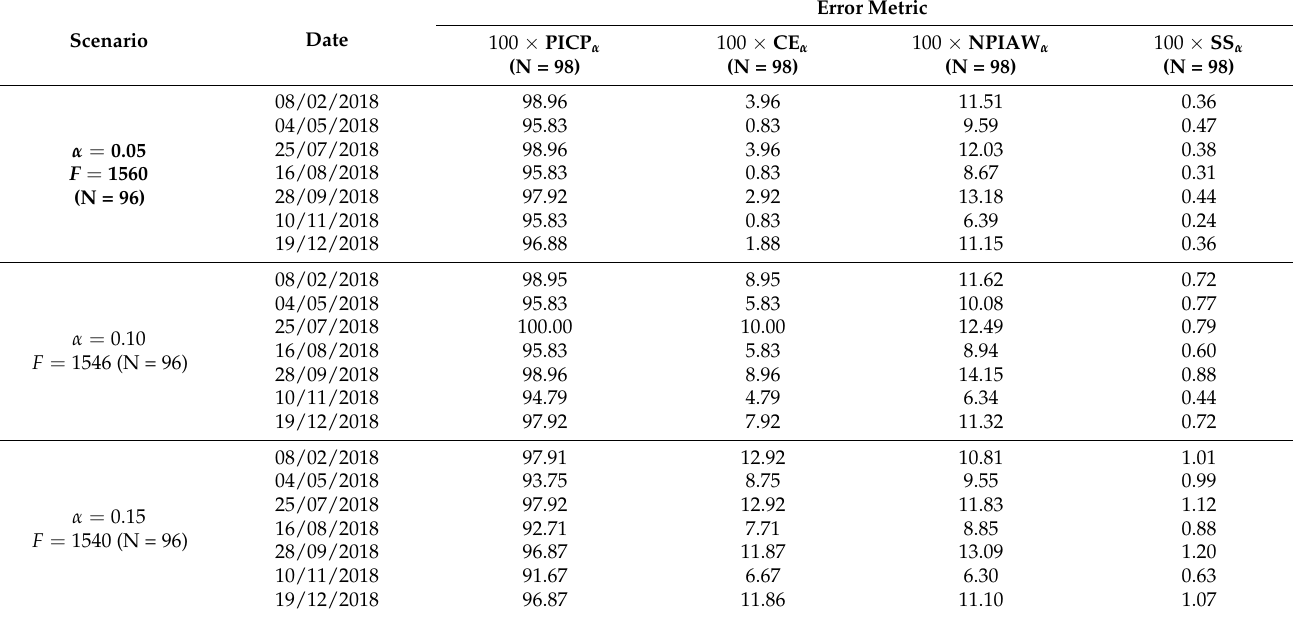
Table 11. Computed error metrics for the examined scenarios ( F, α )